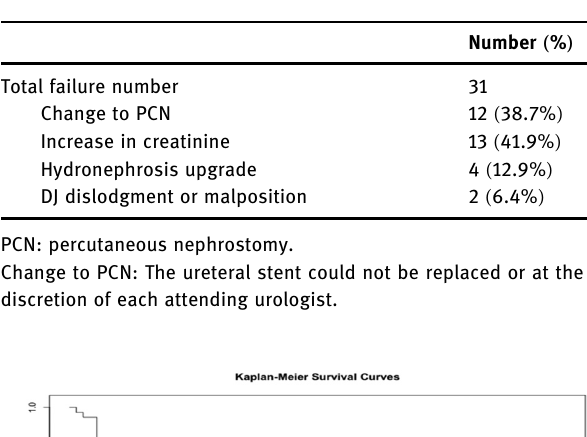
Table 2: Causes of stent failure